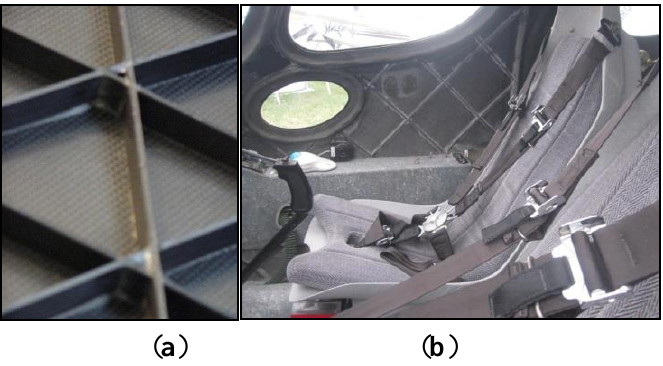
Figure 19. Example of advanced grid structure made of CFRP ( a ) and its application to an aerospace structure ( b ).